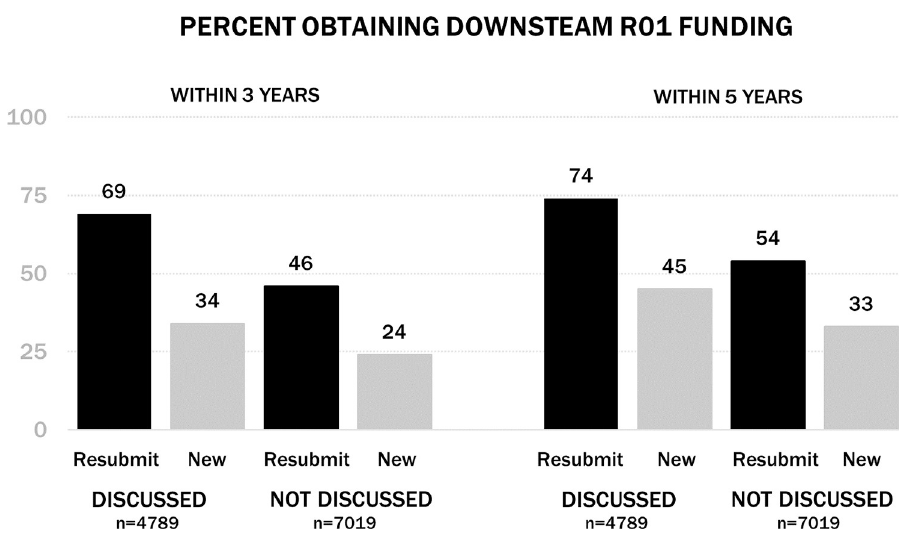
Fig 1. Distribution of obtaining R01 downstream funding,